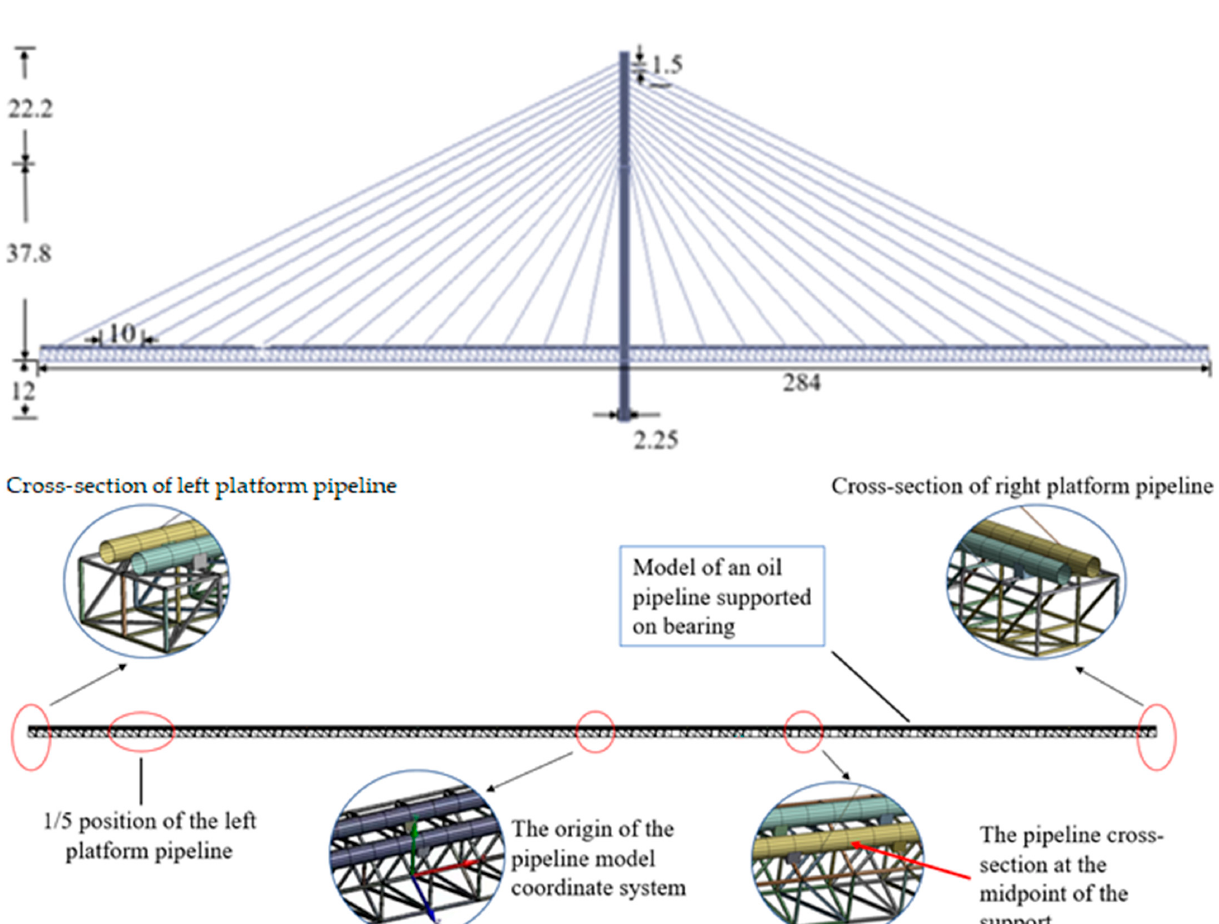
Figure 1. Schematic diagram of the prototype structure of the cable-stayed pipe bridge and the oil and gas transmission pipeline (unit: m). and gas transmission pipeline (unit: